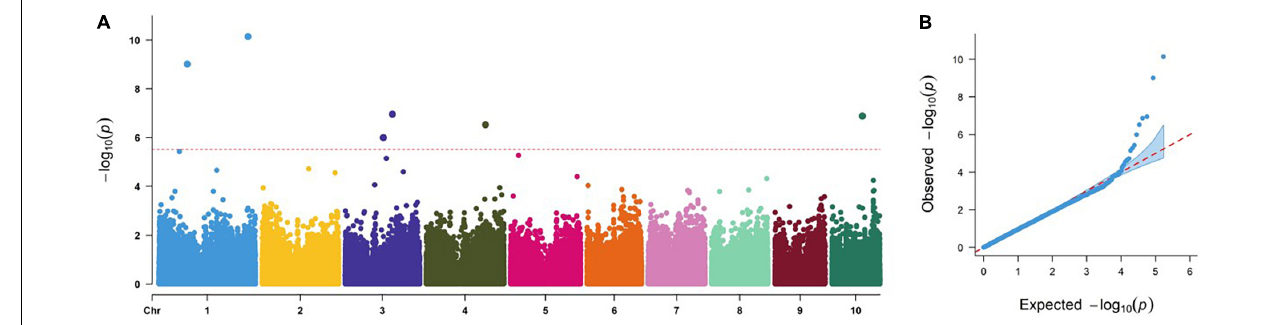
FIGURE 2 | Genome-wide association study Manhattan and quantile–quantile (q–q) plots for common rust resistance in the Drought Tolerant Maize for Africa (DTMA) panel. (A) Manhattan plot, the dashed line corresponds to the threshold level defined at P = 3.70 × 10 − 6 by a false discovery rate correction method; (B) q–q plot. TABLE 3 | Quantitative trait loci detected from the linkage mapping analysis in the doubled haploid (DH1) population. Chromosome Position (cM) Bin Left marker a Right marker LOD b PVE(%) c Additive effect